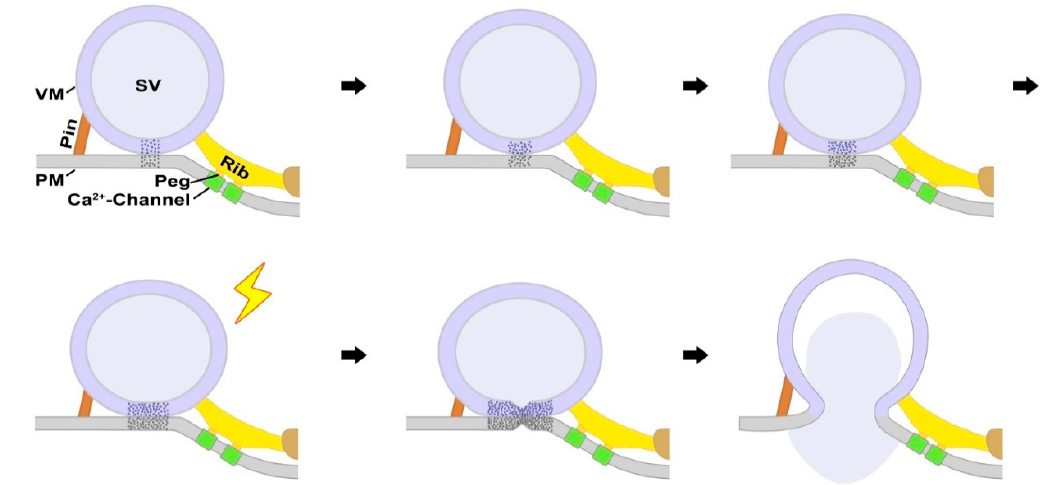
Figure 4. Sequential stages of a synaptic vesicle leading to the formation of the fusion pore through hemifusion for the neurotransmitter release at the active zone of axon terminals of frog NMJs. The vesicle membrane (VM) of a synaptic vesicle (SV) is in contact with the presynaptic membrane (PM) at the active zone of the frog NMJ (indicated by stipples). The docked vesicle is connected to several AZM components, such as ribs and pins. Ribs link the vesicle membrane to the presynaptic membrane via pegs, which are connected to PM macromolecules thought to include Ca 2 + channels (See Jung et al. [45]). The vesicle membrane of the docked vesicle increases its contact area with the presynaptic membrane, by the shortening of its AZM components directly linking the vesicle membrane to the presynaptic membrane, without detectable merging between the membranes. The further shortening of the AZM components increases the contact area more. When an action potential arrives at the active zone, the vesicle membrane and the presynaptic membrane are hemifused, enhancing the contact area further by the attractive force generated by the greater shortening of the AZM components, leading to the formation of an irreversible fusion pore. As the pore expands, releasing the neurotransmitter contained in the vesicle for synaptic transmission, the vesicle membrane flattens into the presynaptic membrane.